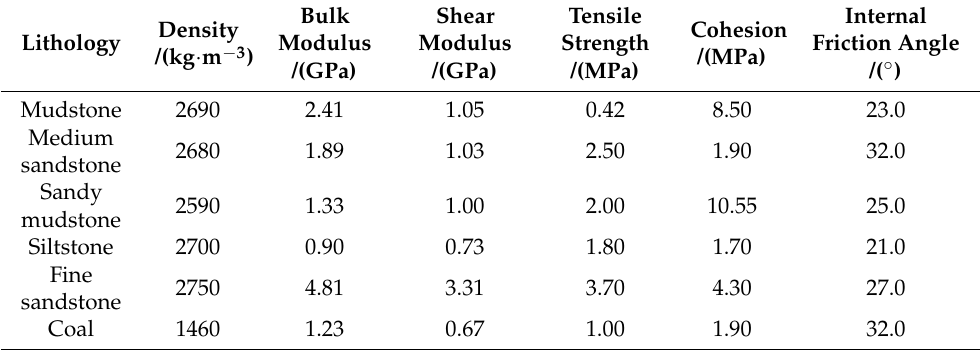
Table 2. Rock mass mechanical parameters.